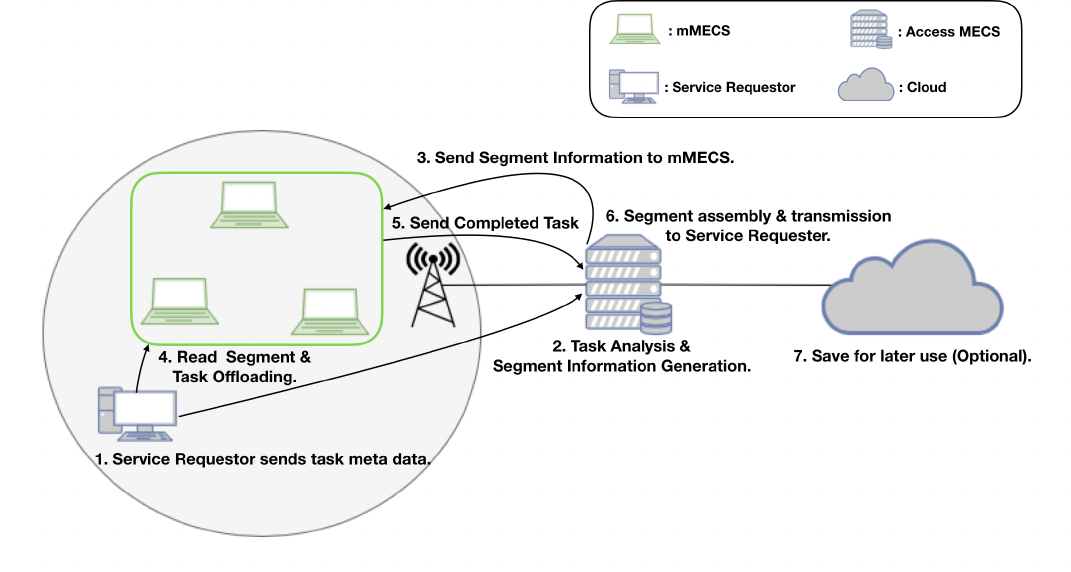
Figure 2. The components and operation steps of the proposed scheme. Table 1. Description of the elements of the proposed